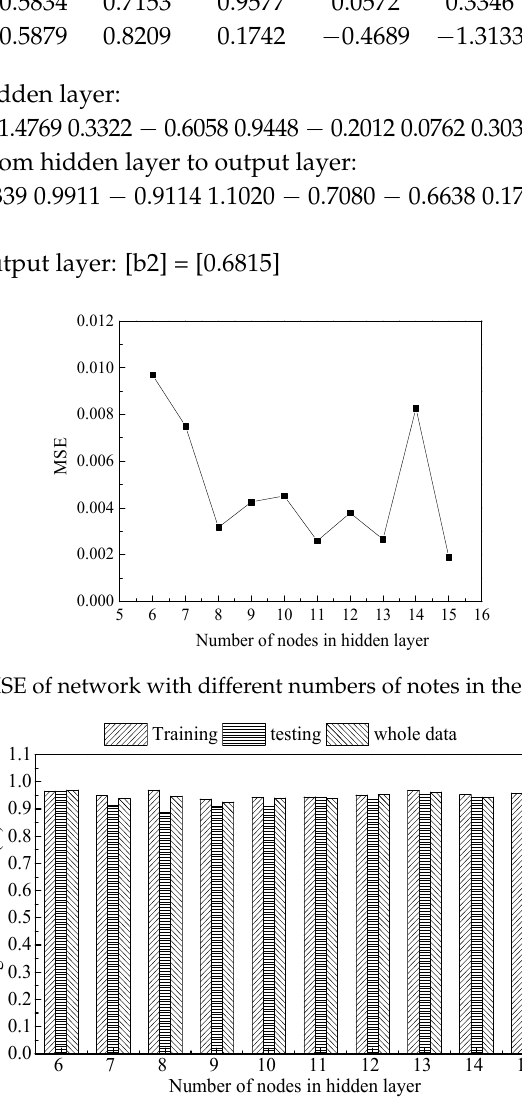
Figure 10. Final network configuration used in present study. 3.2. Support Vector Machine SVM is an intelligent algorithm first proposed by Boser et al. in 1992 for general classification problems [42]. It is based on the principle of structural risk minimization (SRM), which aims to minimize an upper bound on the expected risk rather than minimizing the error of the training